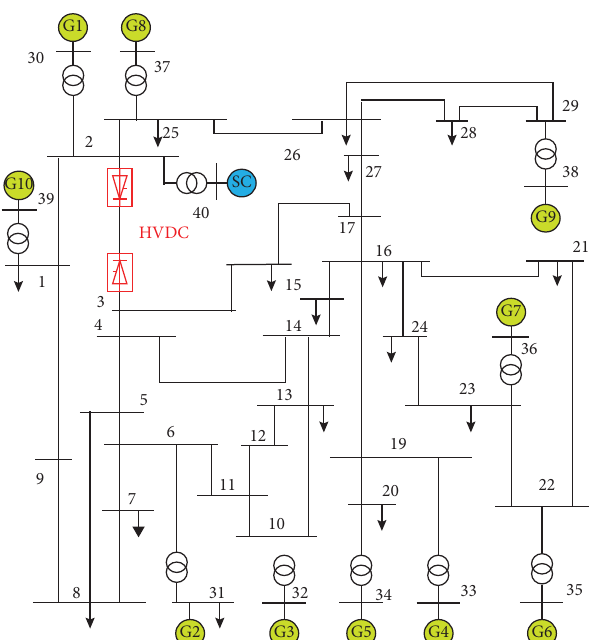
Figure 5: IEEE 39-bus test system with HVDC line.